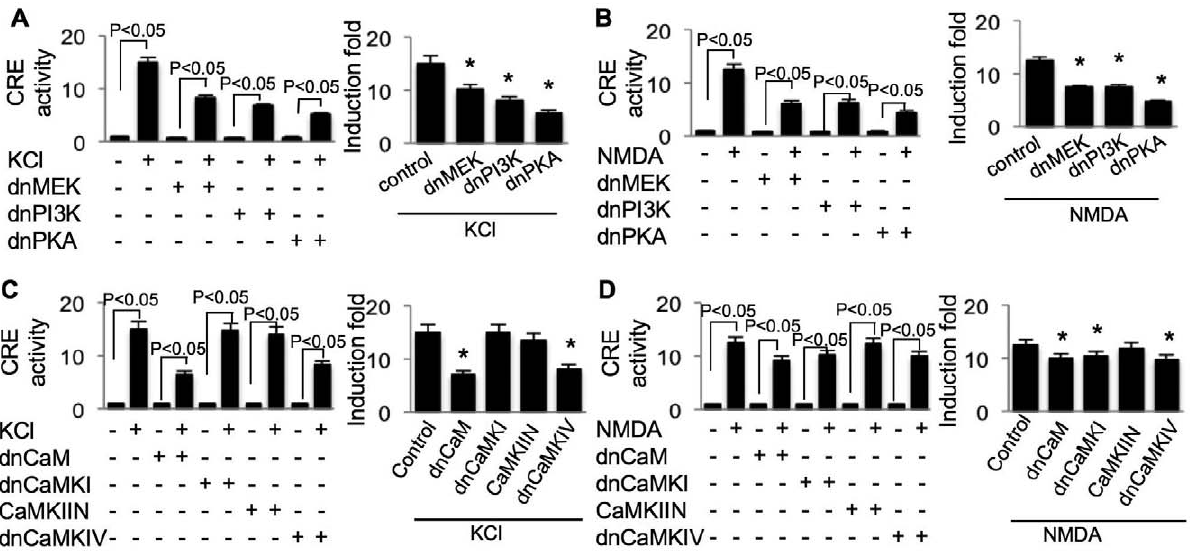
Figure 7. Regulation of CRE by Ca 2 + -stimulated protein kinases. The CRE-luciferase reporter construct plus TK-pRL along with the dominant negative construct of Ca 2 + -stimulated protein kinases (dnMEK, dnPI3K, and dnPKA for A and B; dnCaM, dnCaMKI, CaMKIIN, and dnCaMKIV for C and D) were transfected into cortical neurons on DIV 9. SV40-luciferase plus TK-pRL along with different dominant negative construct were transfected into another set of neurons for normalization purposes. On DIV 11, neurons were treated with 50 mM KCl (A and C) or 20 m M NMDA (B and D). Dual luciferase assay was performed after the six-hour incubation with KCl or NMDA. After normalized to Renilla luciferase activity, CRE activity was further normalized to SV40 activity, and expressed as relative values. In the right panels, the effect of dn construct on KCl- or NMDA-stimulated transcription was normalized to the dn construct-only group (*: statistically different to that of the KCl- or NMDA-stimulated transcription in neurons not expressing any dn construct). Data were collected from 8 independent preparations for each